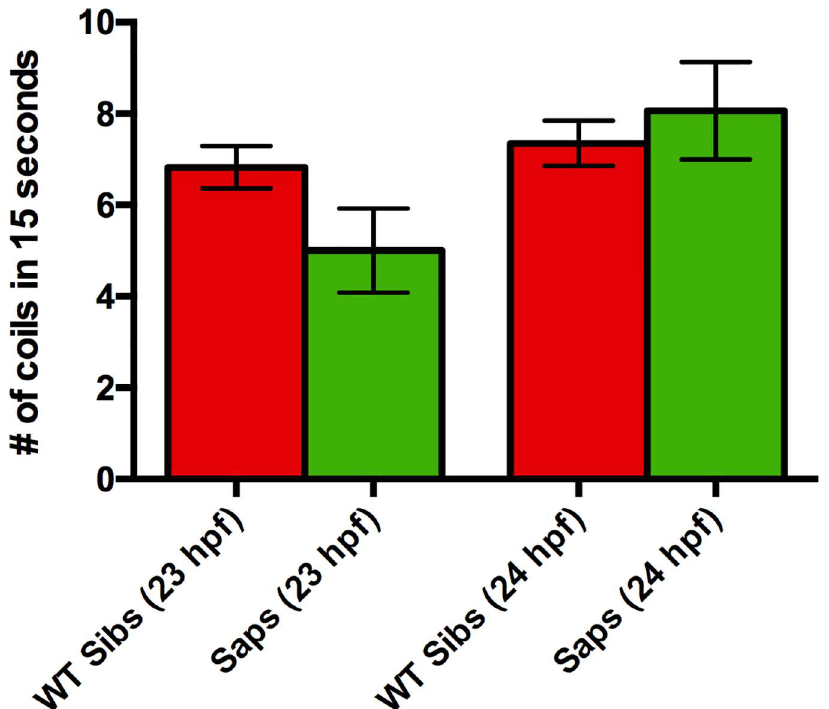
Fig 6. Coiling deficiency is not observed in the zebrafish model of Duchenne muscular dystrophy. Sapje mutants, the zebrafishmodel of Duchennemuscular dystrophy, do not present with a coilingphenotype at 23 hpf (WT sibs: 6.823 ± 0.4642, n = 62; cafs : 5.000 ± 0.9244, n = 11; p = 0.1088) or 24 hpf (WT sibs: 7.347 ± 0.4950, n = 72; cafs : 8.063 ± 1.066, n = 16; p = 0.9997). Bars represent mean ±